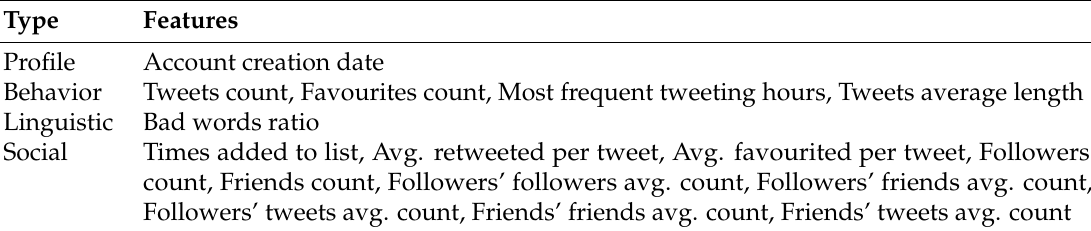
Table 1. Twitter features.